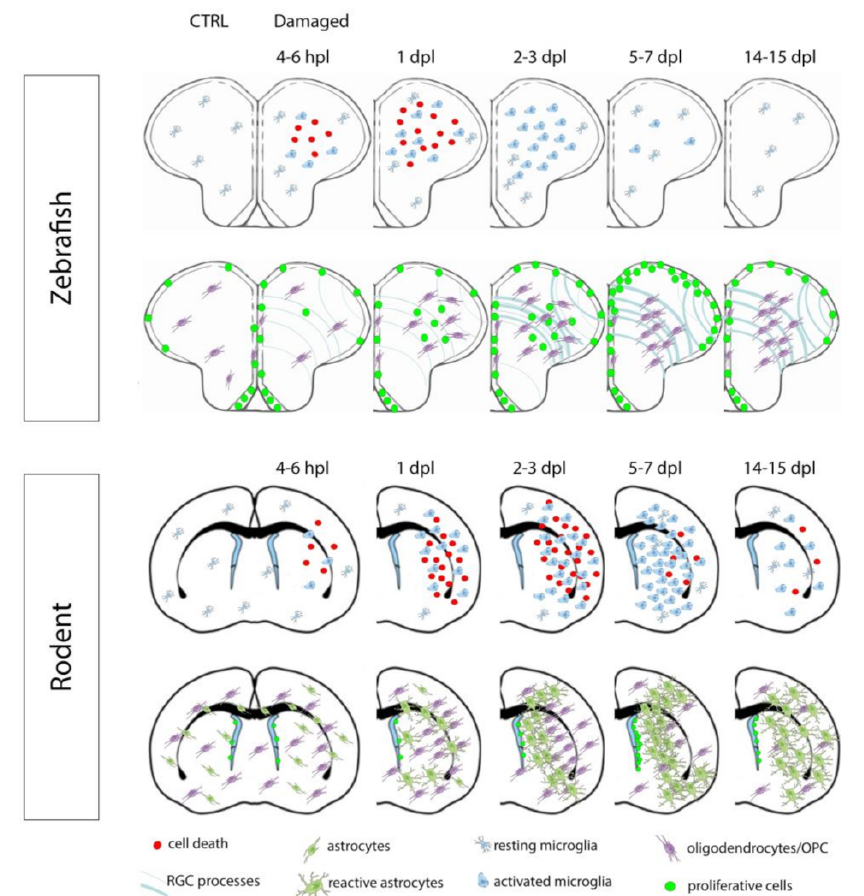
Figure 3. Cellular events occurring after telencephalic injury in zebrafish and stroke in mouse. After brain damage, numerous cells, mainly neurons, die. This process is followed by the activation and re- cruitment of microglial and other immune cells (leukocytes) in parallel to OPCs. Then an astrogliosis process occurs in mice, while RGCs become reactive and proliferative in zebrafish. Proliferation in the neurogenic niches peak at day 7 after damage in both models. Note that the cellular response on the contralateral side is not shown for zebrafish and rodent. In zebrafish and rodent, the first row shows cell death, microglial recruitment, and activation. In zebrafish, the second-row highlights the hypertrophy of RGC processes, the neurogenic injury-induced proliferation as well oligoden- drocytes/OPCs response. In rodents, the second row shows astrogliosis, neurogenic proliferation along the SVZ and oligodendrocytes/OPCs response. Note that in zebrafish oligodendrocytes/OPCs accumulate close to the lesion site without increasing their number; dpl: day(s) post lesion, hpl: hour(s) post